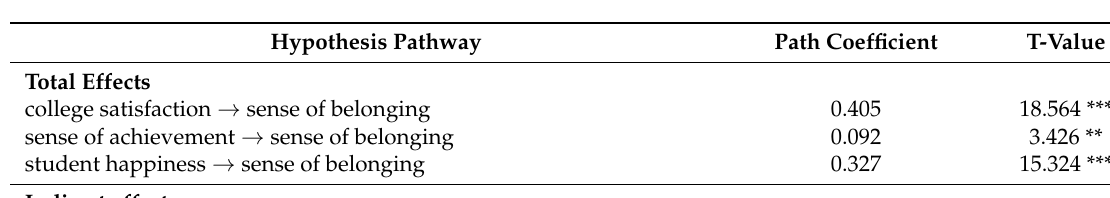
Table 4. Mediation effect results.